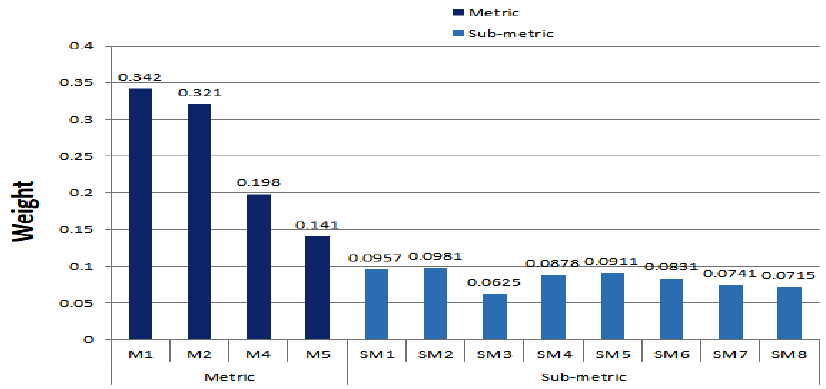
Figure 5. Ranking of Metric for scenario 1.